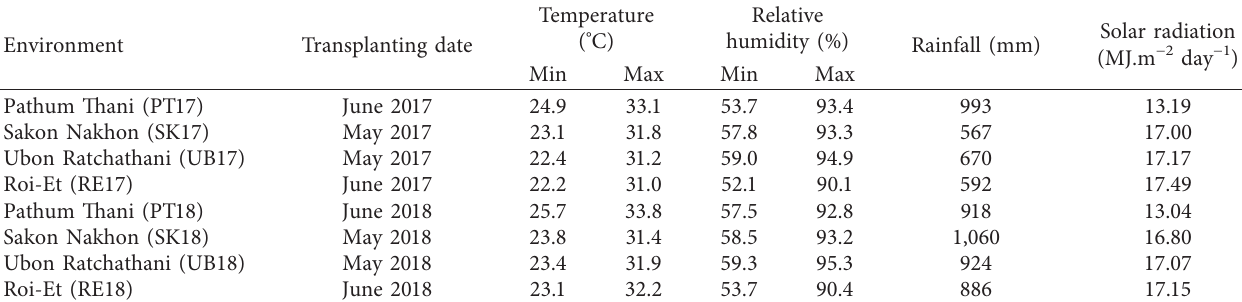
Red Moderate level of most lipid compounds but low β -sitosterol and squalene G, glutinous rice; NG, nonglutinous rice. Table 2: Meteorological conditions in Pathum Thani, Sakon Nakhon, Ubon Ratchathani, and Roi-Et provinces in the 2017 and 2018 growing